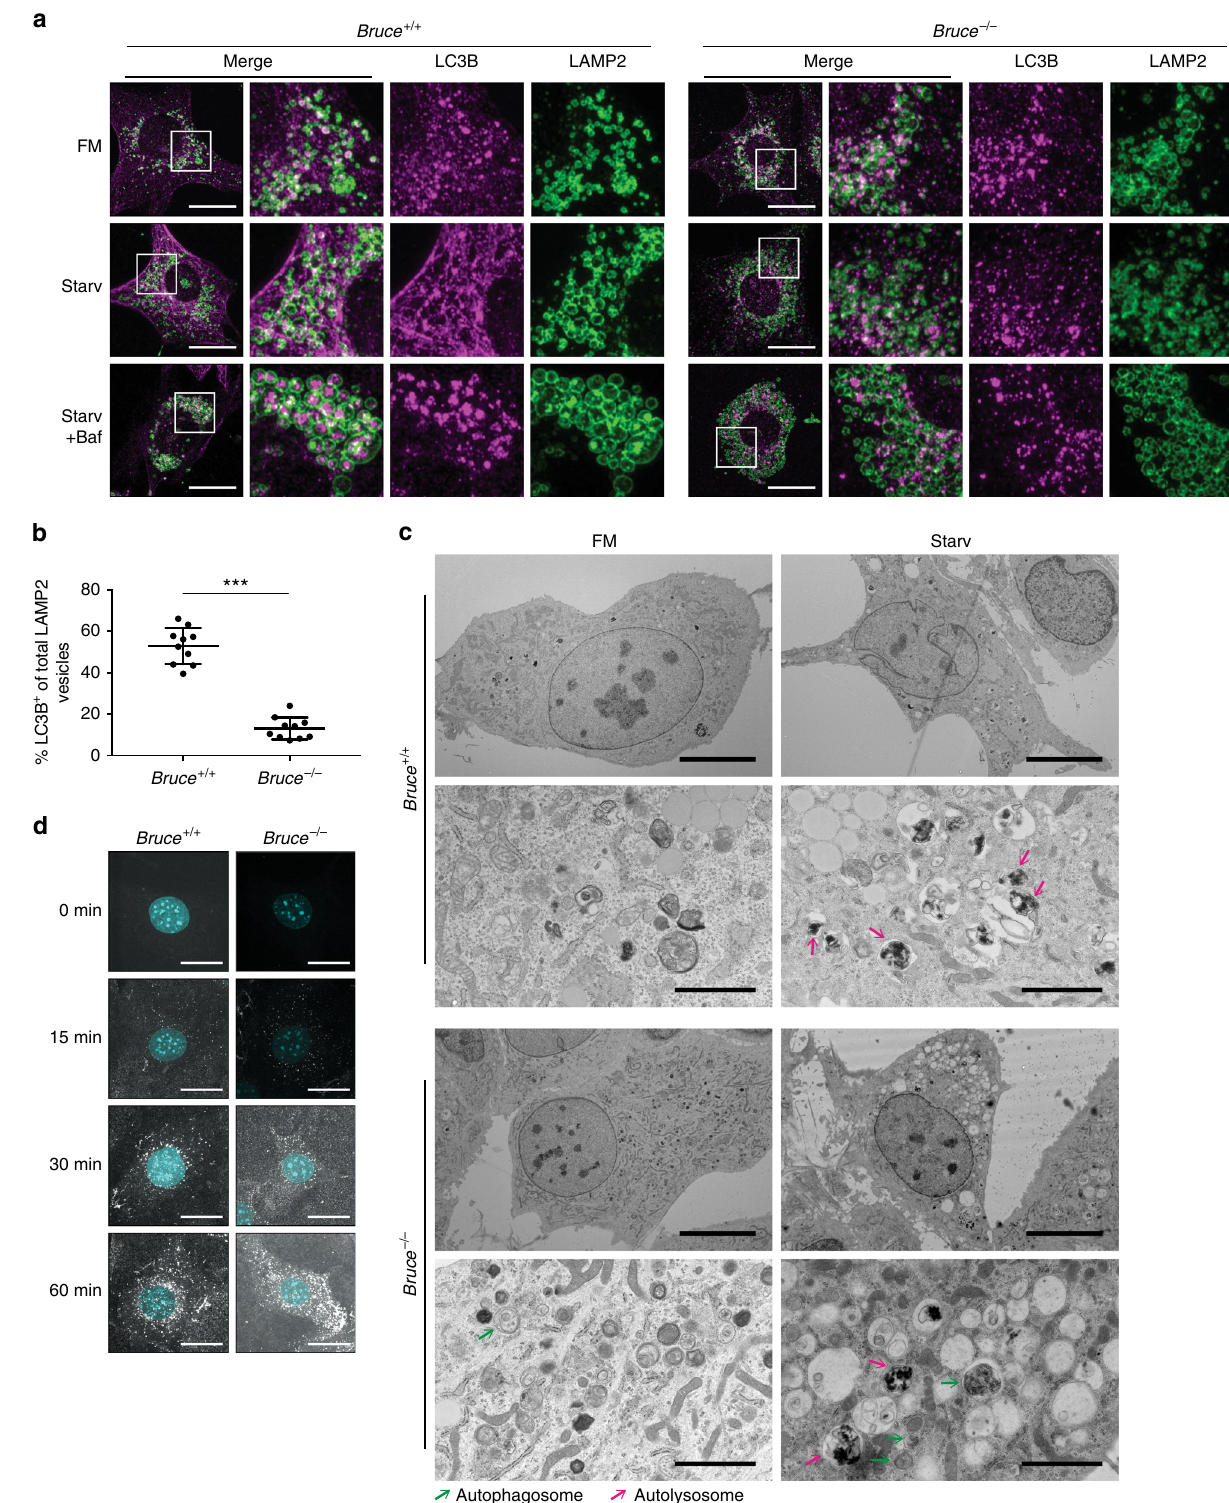
Fig. 5 BRUCE controls autolysosome formation. a Immuno fl uorescent staining of endogenous LC3B and LAMP2 in Bruce + / + and Bruce − / − MEFs. Bruce + / + and Bruce − / − MEFs in fully supplemented medium (FM), starved (Starv) for 4 h with or without Ba fi lomycin A1 (Baf; 100 nM) were fi xed and stained with anti-BRUCE and anti-LAMP2 antibodies. Scale bars, 20 µ m. b Percentage of LAMP2-positive vesicles containing LC3B-positive aggregates in MEFs under starvation condition with Ba fi lomycin A1 treatment as in a . Data are presented as dot plots with mean ± SD (*** p < 0.001, analyzed by t -test); n = 10 cells. c Electron microscopic images of Bruce + / + and Bruce − / − MEFs in FM or starved for 2 h. Overview: scale bars, 10 µ m; magni fi ed: scale bars, 2 µ m. Green and pink arrows point to autophagosomes and autolysosomes, respectively. d Examination of the endosomal/lysosomal pathway by confocal microscopy using DQ-Ovalbumin in Bruce + / + and Bruce − / − MEFs. Cells were grown in DQ-Ovalbumin containing starvation media for the indicated time. Scale bars, 20 µ